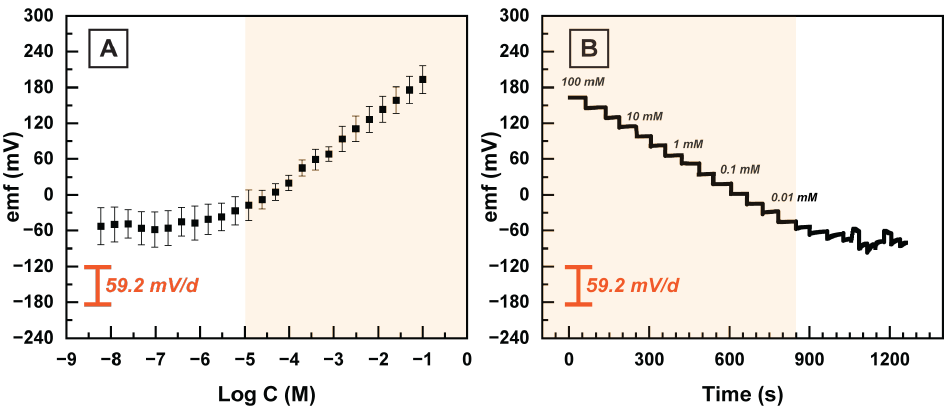
Figure 5. ( A ) The response of the HERS electrodes to TMA + (n = 5) with TMA-selective polymeric sensing membrane. ( B ) The emf value of the HERS electrode over time during successive dilution of TMA + solution. Highlighted regions correspond to the linear range, 10 µM to 100